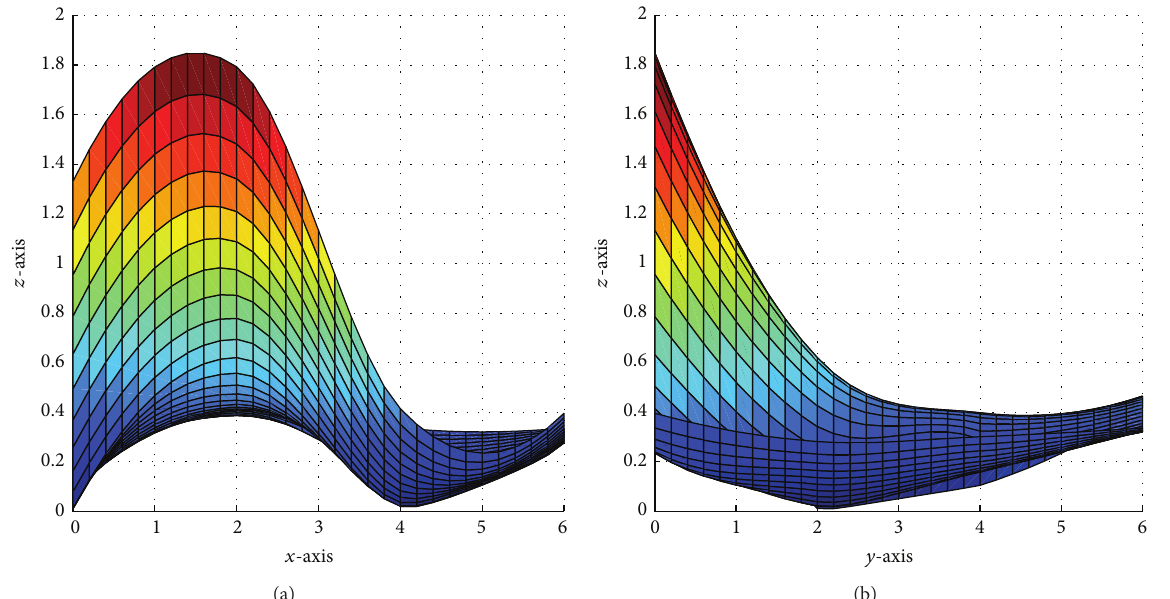
Figure 5: Positivity preserving surface: (a) 𝑥𝑧 -view and (b) 𝑦𝑧 -view for Figure 4, respectively.